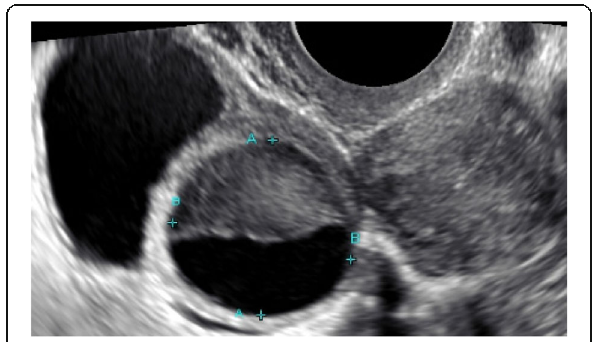
Fig. 1 TVUS showing adnexal cysts (simple and complicated)